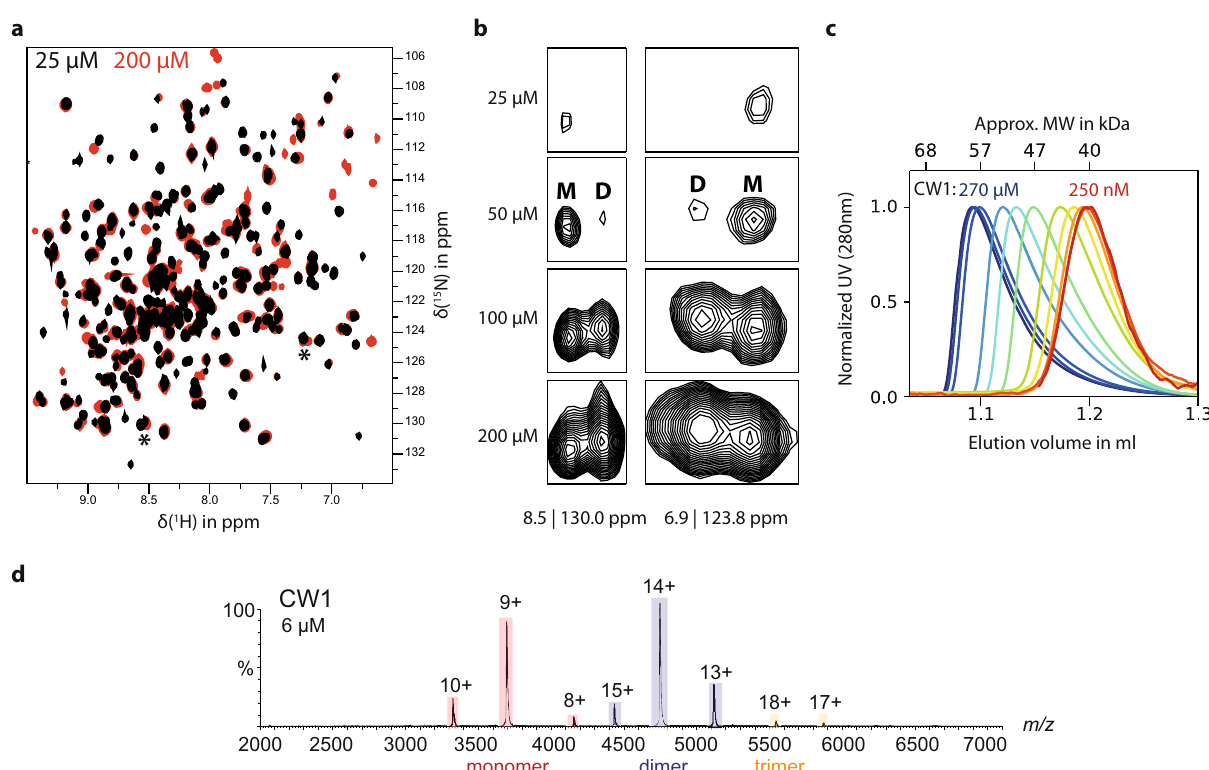
Fig. 1 Concentration-dependent dimerization of the MNV P-domain in solution. a 1 H, 15 N TROSY HSQC spectra of [ U - 2 H, 15 N] labeled MNV CW1 P-domains show protein concentration-dependent changes (black: 25 µ M, red: 200 µ M). Several new backbone NH signals appear with increasing protein concentration while others decrease in relative intensity. b These signals can be assigned to originate from the dimer (D) or the monomer (M), respectively. Two selected signal pairs are shown (marked by asterisks in a ). c CW1 P-domains have been subjected to size-exclusion chromatography at increasing concentrations, ranging from 250 nM (red) to 270 µ M (blue). The elution volume strongly depends on protein concentration and can be associated with an increase of apparent molecular weight (Fig. S4) from 39.6 kDa (monomer) to 58.4 kDa (dimer). The normalized chromatograms reveal a noticeable peak tailing at higher concentrations, indicating ongoing monomer-dimer exchange on the time scale of the chromatographic separation. d Native mass spectra of CW1 P-domains con fi rming monomer-dimer